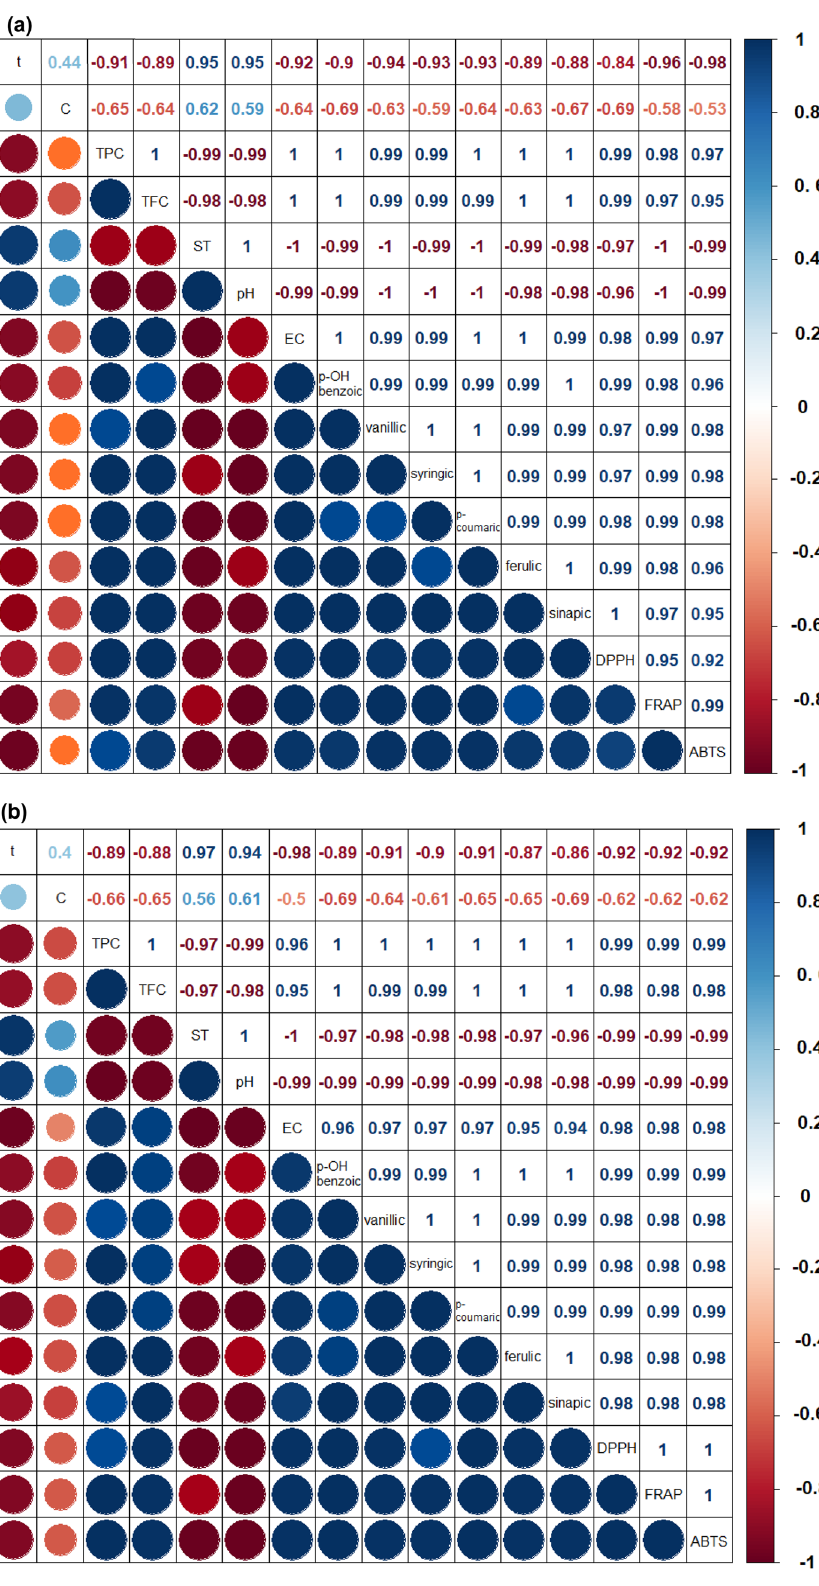
Figure 4. Correlations between TPC, TFC, phenolic acid content, antioxidant activities and extraction parameters; ( a ) UAE with ethanol, ( b ) MAE with ethanol. Positive correlations are displayed in blue and negative correlations in red. Color intensity and the size of the circles are proportional to the correlation coefficients. Values of Spearman’s rank correlation coefficient above 0.6 are described as a strong correlation; t— extraction time, C—solvent